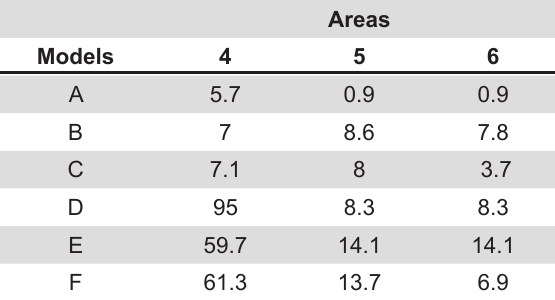
Table 4- von Mises stress ( s according to specific areas (4 to 6) in the models (A to F)